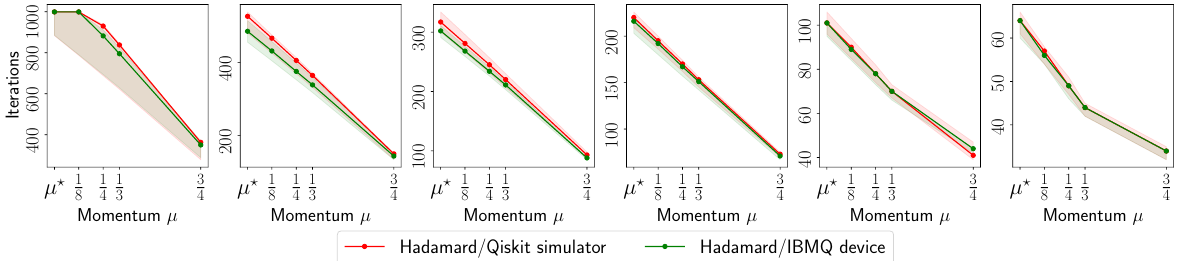
Figure A19. Convergence iteration plots for reconstructing Hadamard ( 8 ) circuit using using real mea- surements from IBM Quantum system experiments and synthetic measurements from Qiskit simulation.